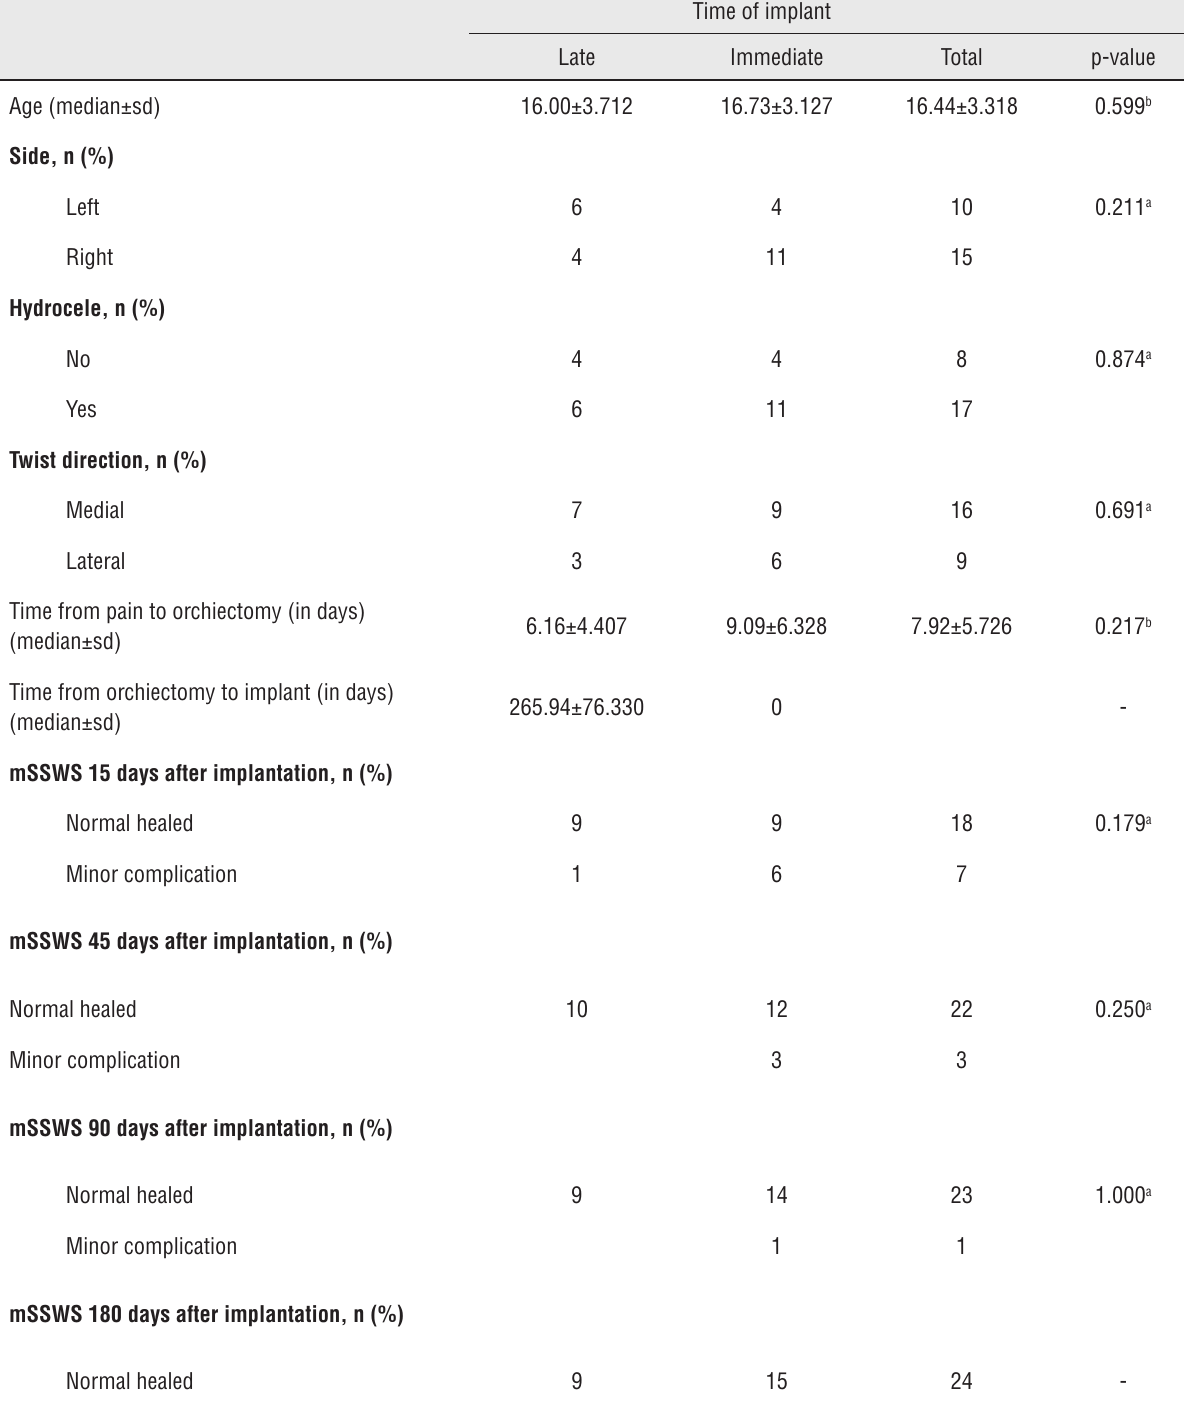
Table 1 - Differences in perioperative characteristics and postoperative outcomes between immediate and late testicular prosthesis